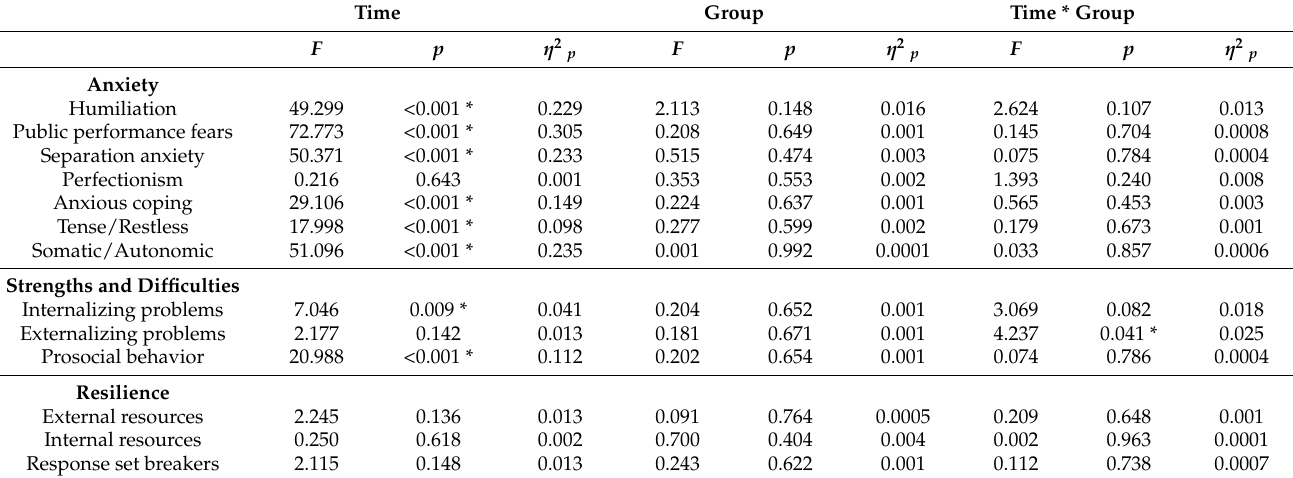
Table 2. ANOVA with repeated